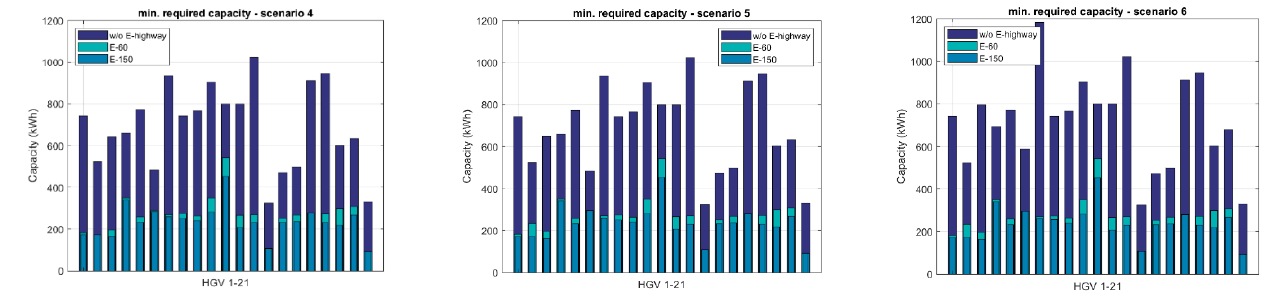
Figure 5. Minimum required capacity — 50 kW charging stations — scenarios 1 – 3 (own illustration).